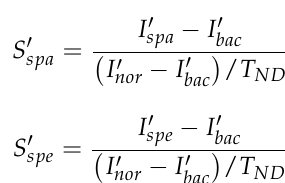
Figure 21. ( a ) Test device for B3 spectrometer, ( b ) spectral lines and SRFs of B3 spectrometer.